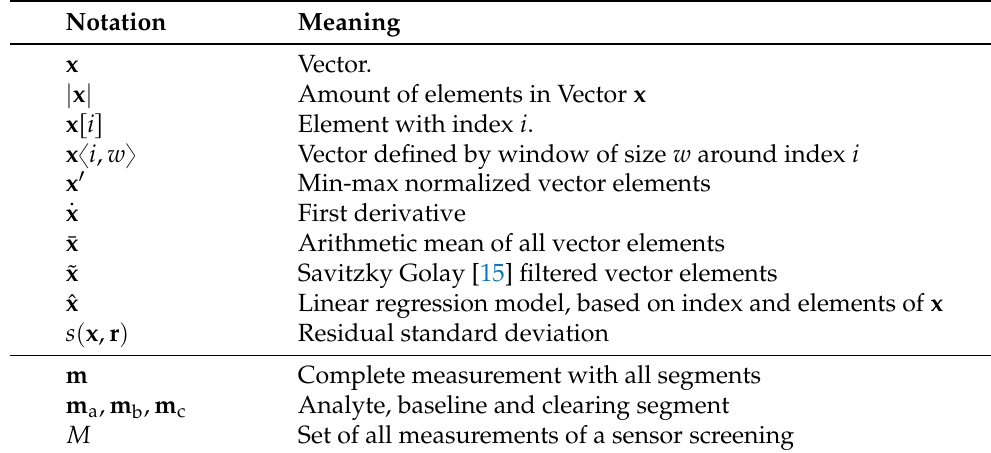
Table 2. Summary of notation conventions for this